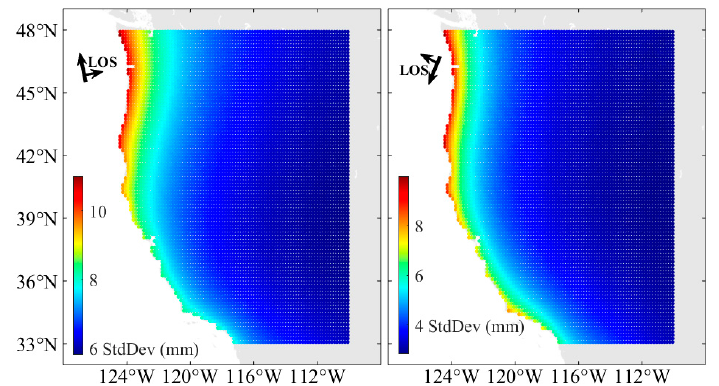
Figure 5. The OTL displacement StdDev along the LOS direction (Incident angle is 39 ◦ ) of the ascend- ing (Heading direction is − 13 ◦ ) and descending (Heading direction is 193 ◦ ) Sentinel-1 measurements with an interval of 12 days based on the proposed OTL calculation